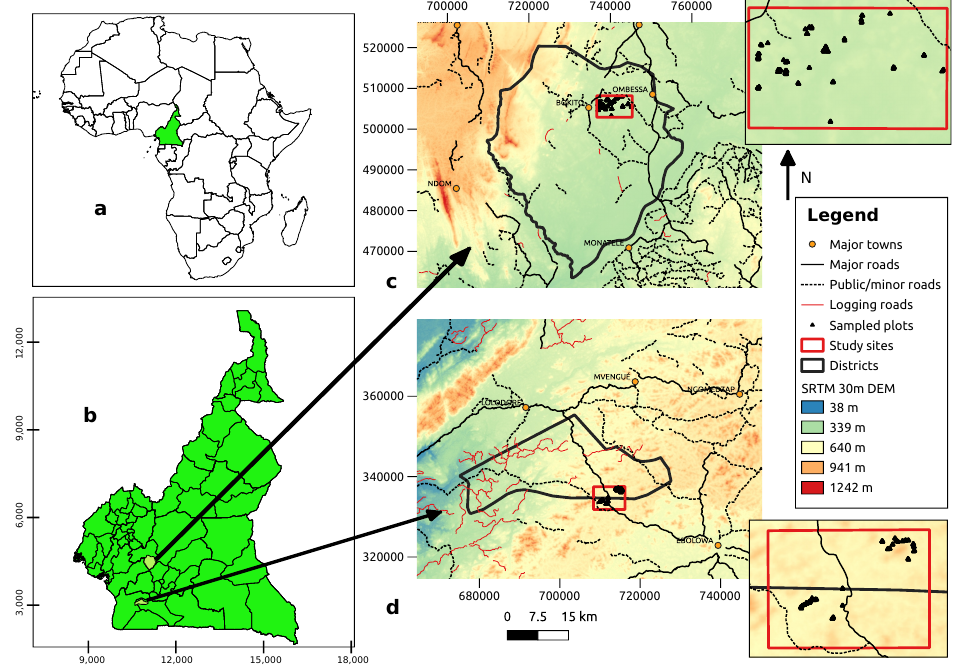
Figure 1. Geographic location of Cameroon and the study sites: ( a ) Cameroon in Africa. ( b ) Districts of the study sites in the Mbam & Inoubou Division of the Center Region and the Mvila Division of the South Region (Map Coordinate Reference System (CRS) is World Geodetic System (WGS) 84, Degree Decimal). ( c ) The forest-savannah transition landscape (study site 1) in the Bokito district (CRS: WGS 84/Universal Transverse Mercator zone (UTM)). ( d ) The forest landscape (study site 2) in the Efoulan district (CRS: WGS 84/UTM). The image inserts in ( c , d ) show sampling locations in each site. (Other data source: World Resources Institute (WRI) Interactive forestry atlas of Cameroon 2013, Shuttle Radar Topography Mission (SRTM) 1 Arc-Second 30 m Global Digital Elevation